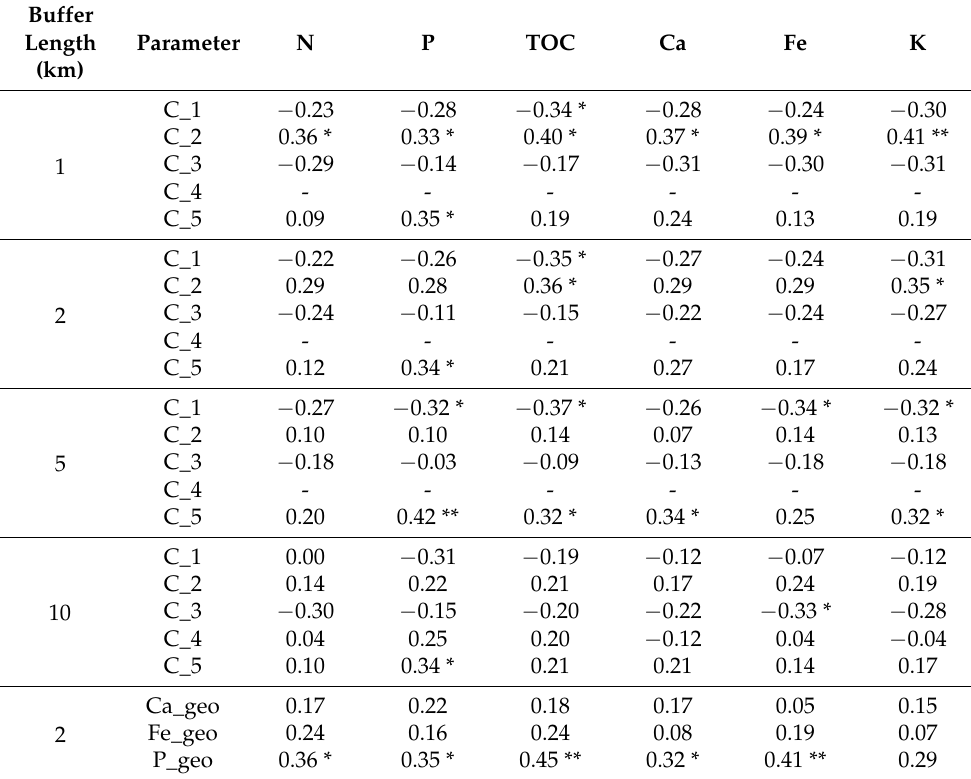
Table 9. Correlation coefficient matrix showing element–land cover and element–geochemical background relationships in sediments.